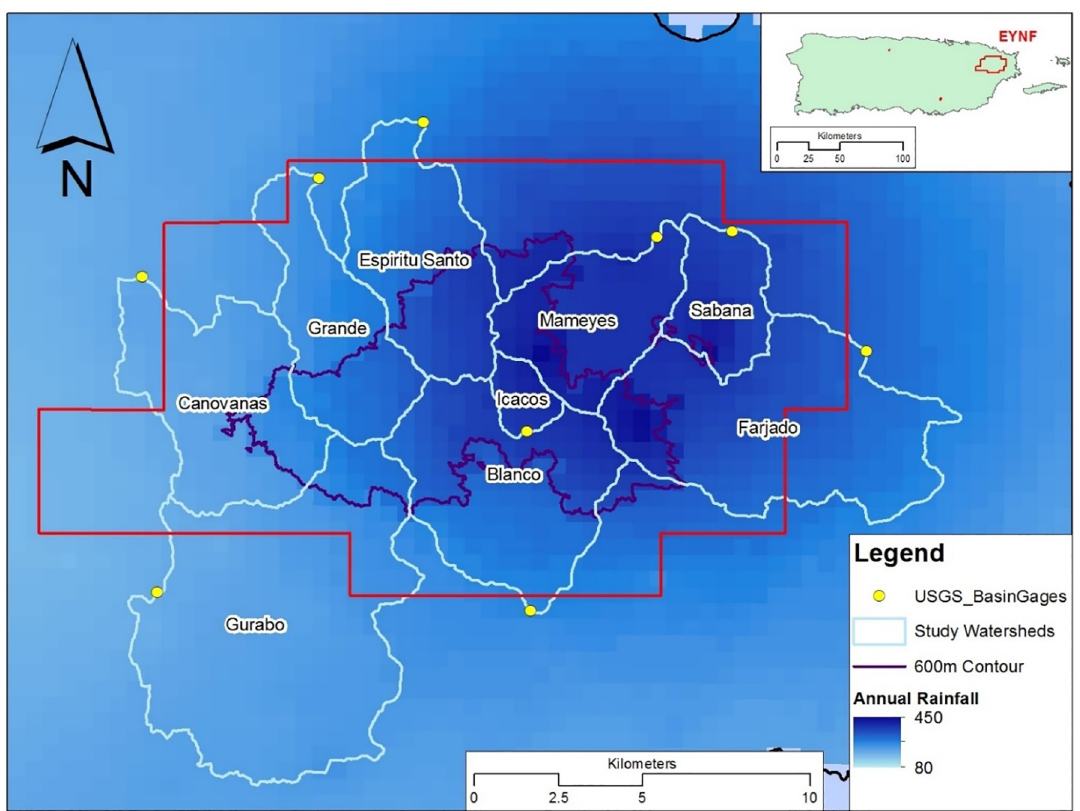
Fig 1. Study area in eastern Puerto Rico with the focal watersheds in the EYNF outlined. The spatial distribution of average annual rainfall (cm) for 2005–2013 from gridded NWS data is shown in the background.